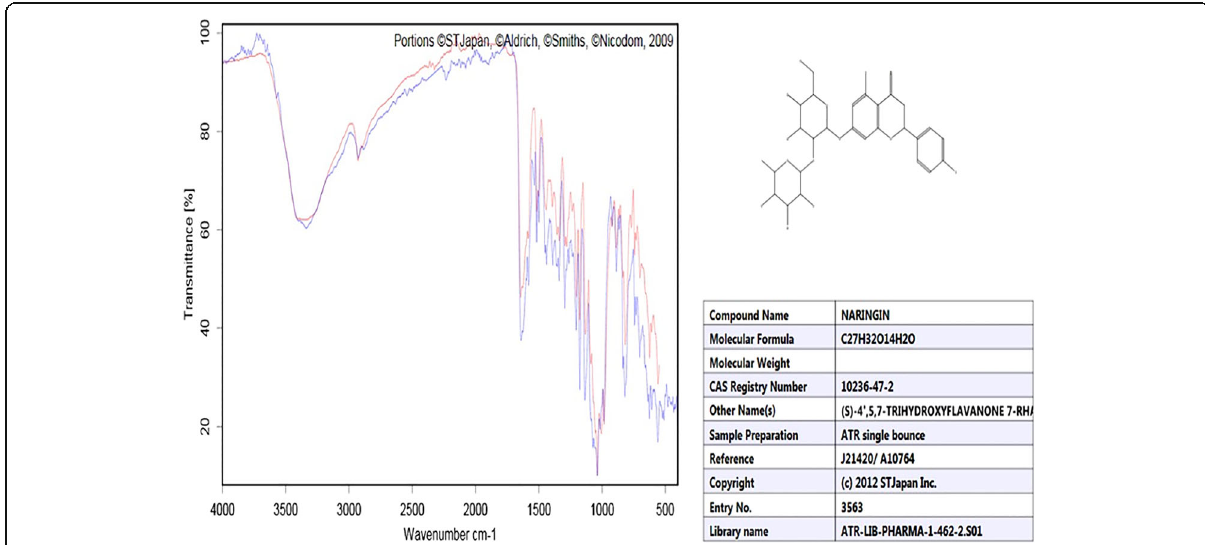
Fig. 1 The reflective index (RI) of naringin measured by infrared (IR) spectroscopy confirmed naringin as the main compound from citrus peel